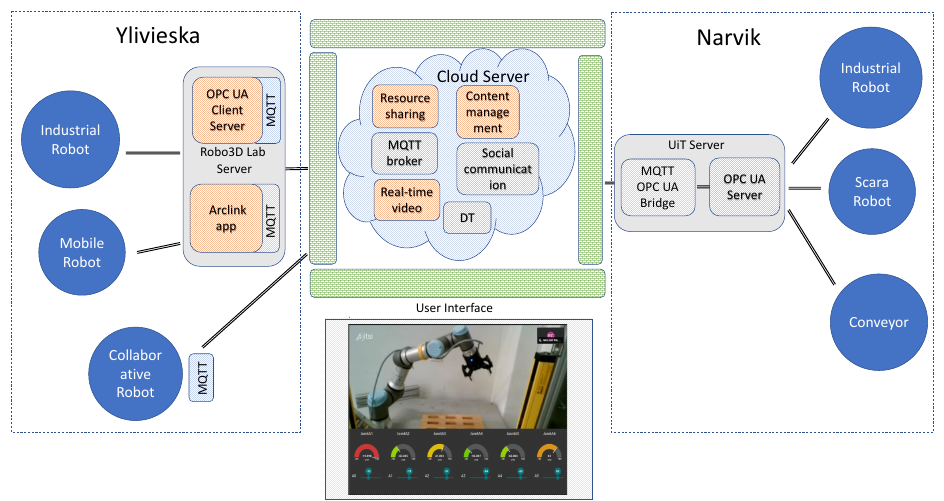
Figure 9. Implementation of proposed